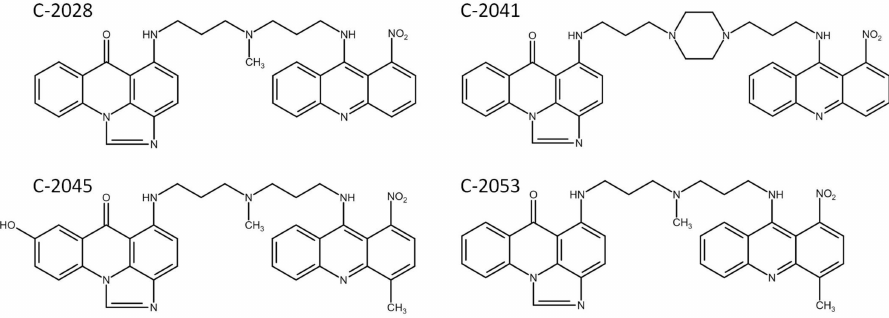
Figure 1. The chemical structures of UA derivatives: C-2028, C-2041, C-2045, and